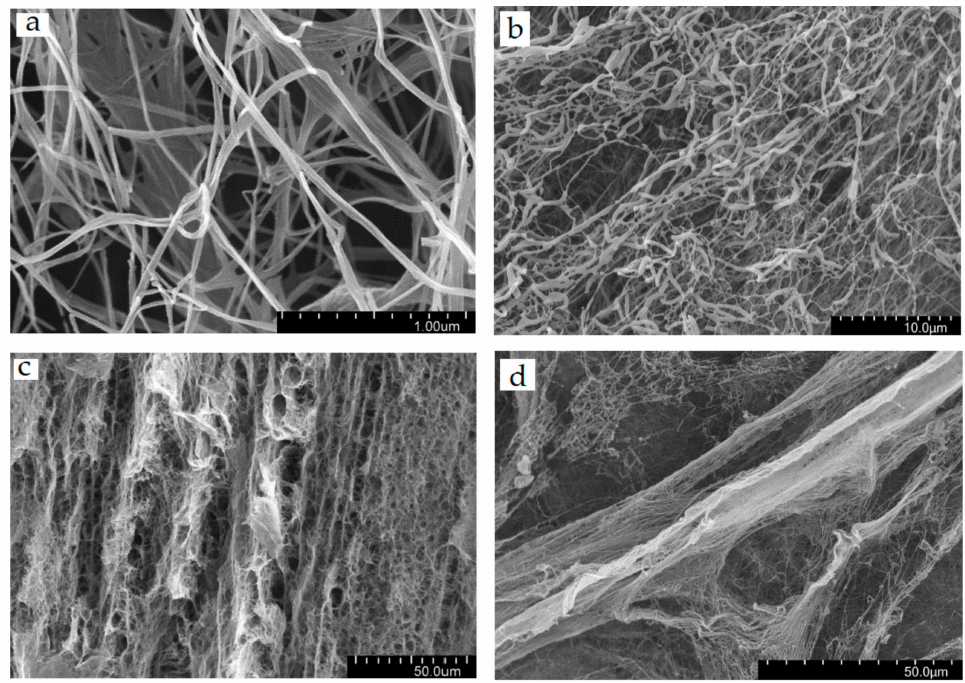
Figure 2. SEM images of the morphology of BCF ( a , c ) and SBCB ( b , d ) at different